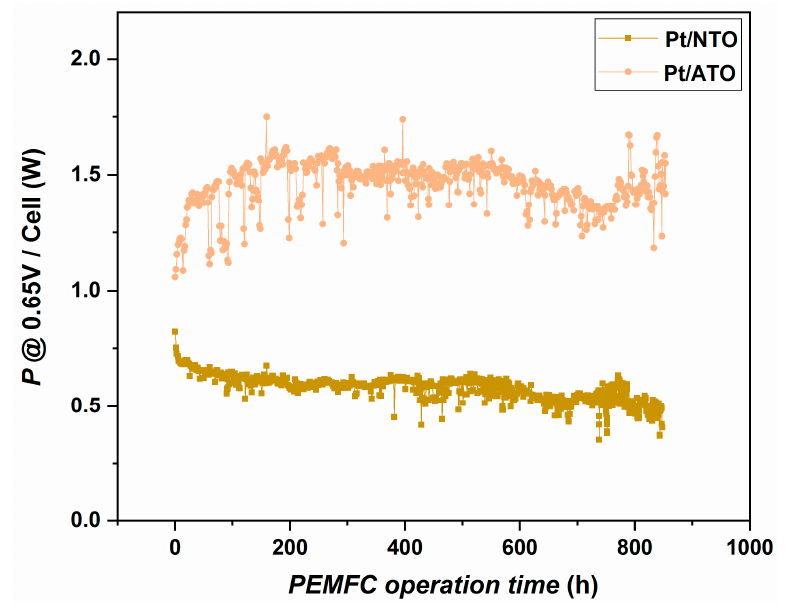
Figure 3. Chronoamperometry at U = 0.65 V for a PEMFC air-breathing system with Pt / ATO and Pt / NTO cathode catalysts.